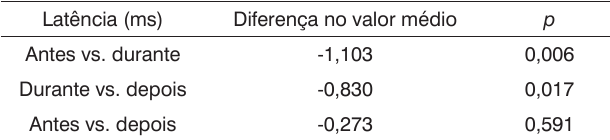
Tabela 3. Teste de Bonferroni para a variável latência.